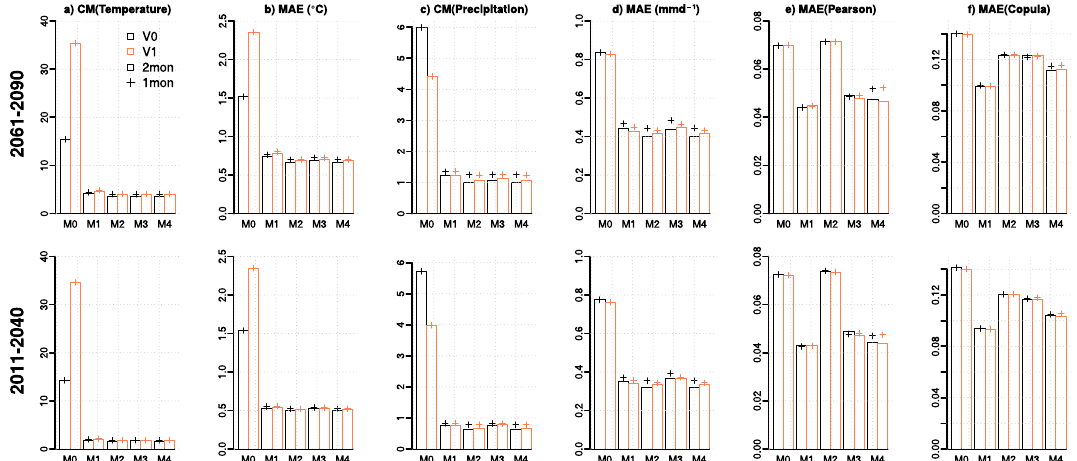
Figure 5. Cross-validated CM and MAE for ( a , b ) daily mean temperature and ( c , d ) daily precipitation distribution in years 2011–2040 ( bottom ) and 2061–2090 ( top ). Also shown are the MAE in ( e ) the Pearson correlation coefficient and ( f ) the empirical copula density. Black color denotes the cross-validation statistics for the pseudo-reality approach without additional adjustments (V0), while the results for the approach where pseudo-realities have been adjusted to biases in relation to WFDEI are shown in red (V1). Furthermore, crosses (bars) indicate the results for the one-month (two-month) time window used to estimate simulated changes or model biases, shown for both V0 and V1. Note that the differences between the one- and two-month time windows are typically small, as indicated by the small differences between the bars and